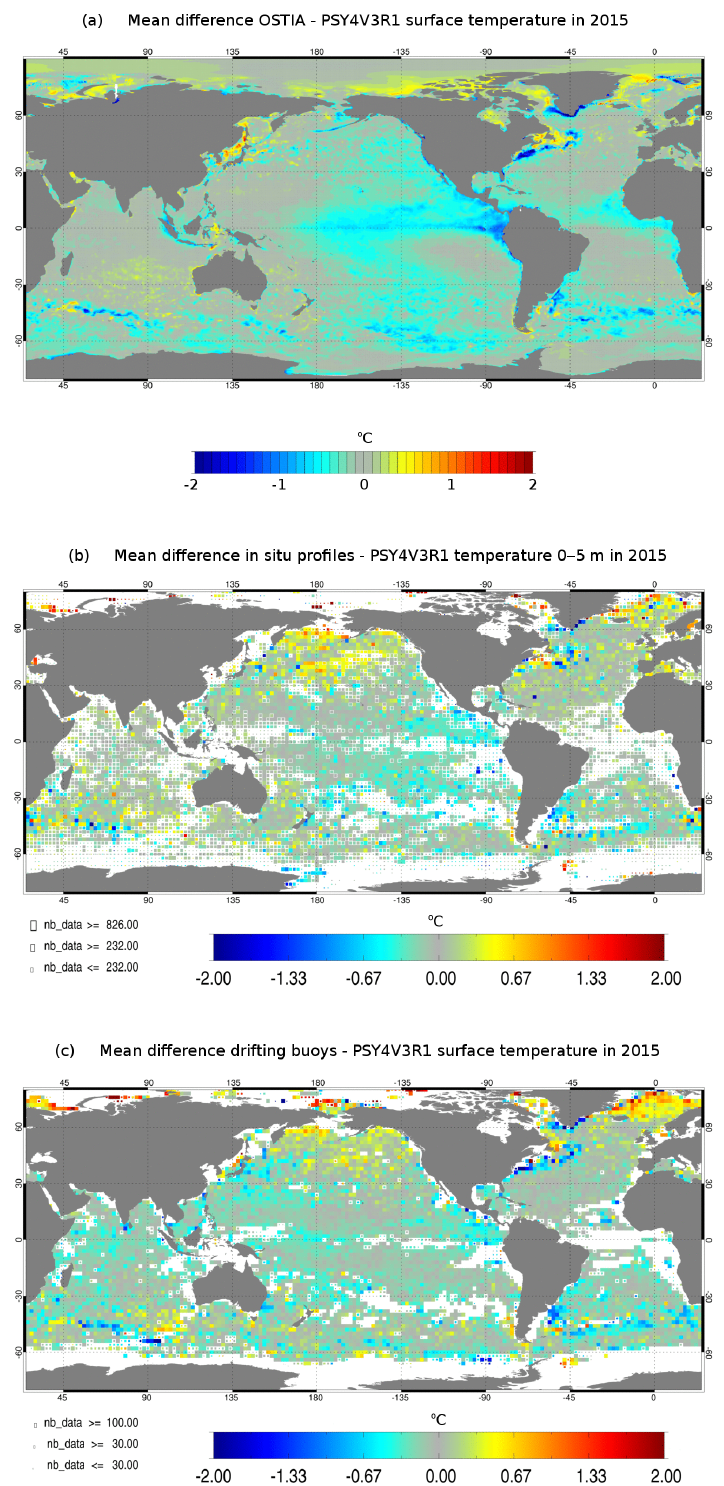
Figure 20. Mean SST residuals (units in ◦ C) over the year 2015: OSTIA SST minus PSY4V3 (a) , in situ SST minus PSY4V3 (b) and drifting buoys SST minus PSY4V3 (c)